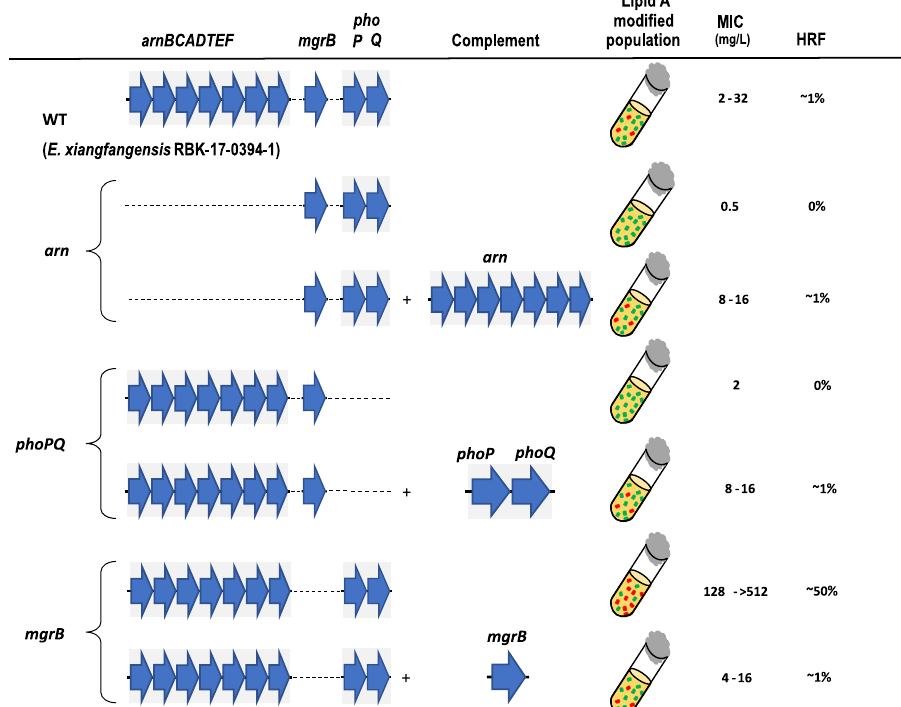
Fig. 3 | Genetic determinants of heteroresistance in Enterobacter species. Comparative genomics of colistin-resistant and -sensitive isolates revealed that arnBCADTEF is necessary for colistin heteroresistance. In Enterobacterales , arnB- CADTEF expressioniscontrolledbytheTCSPhoPQ,whiletheactivityofthePhoPQ pathway is inhibited by the small transmembrane protein MgrB. Deletion mutants werecreatedin E.xiangfangensis L-1isolateRBK-17-0394-1(WT)andstudiedforthe MIC LB andHRF(numberofcellsrecoveredonLBagarplatecontaining8or32mg/L